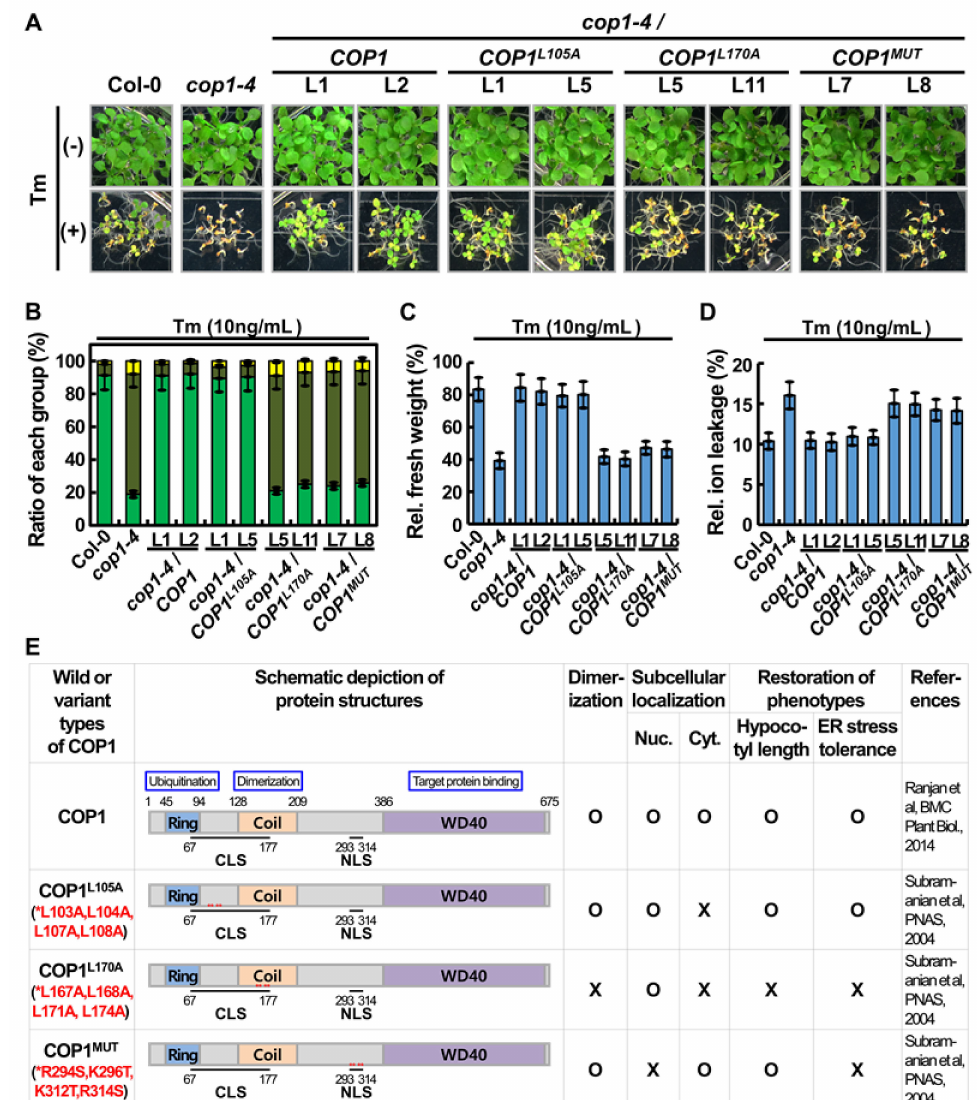
Figure 3. Phenotypic analyses of diverse cop1-4 complementation lines under ER stress. ( A ) Repre- sentative photographs of seedlings of the WT (Col-0), cop1-4 mutant, and selected cop1-4 comple- mentation lines expressing COP1 , COP1 L105A , COP1 L170A , and COP1 MUT grown on the MS media supplemented with 10 ng/mL Tm (+Tm) or no Tm ( − Tm) under an LD photoperiod for 2 weeks. ( B ) Percentage of Tm-treated plants of each genotype in each of the three classes, G-B, G-S, and Y-S, depending on their sensitivity to Tm. Data represent mean ± SD ( n = 3). ( C , D ) Relative fresh weight ( C ) and electrolyte leakage ( D ) of plants of each genotype treated with 10 ng/mL Tm. Data represent mean ± SD ( n = 3). ( E ) Tabulation of the properties of COP1, COP1 L105A , COP1 L170A , and COP1 MUT proteins. The RING domain (Ring) is important for the ubiquitination of target proteins. The coiled-coil motif (Coil) is important for COP1 dimerization. The C-terminal WD40 domain (WD40) plays an important role in the binding of COP1 to its target proteins. Red asterisks indicate the locations of amino acid substitutions in the three COP1 variants. The ability of each protein to localize to the nucleus (Nuc.) or cytosol (Cyt.), to dimerize, to restore the hypocotyl elongation phenotype under dark condition, and to rescue the ER stress-sensitive phenotype of the cop1-4 mutant are indicated by O (Yes) or X